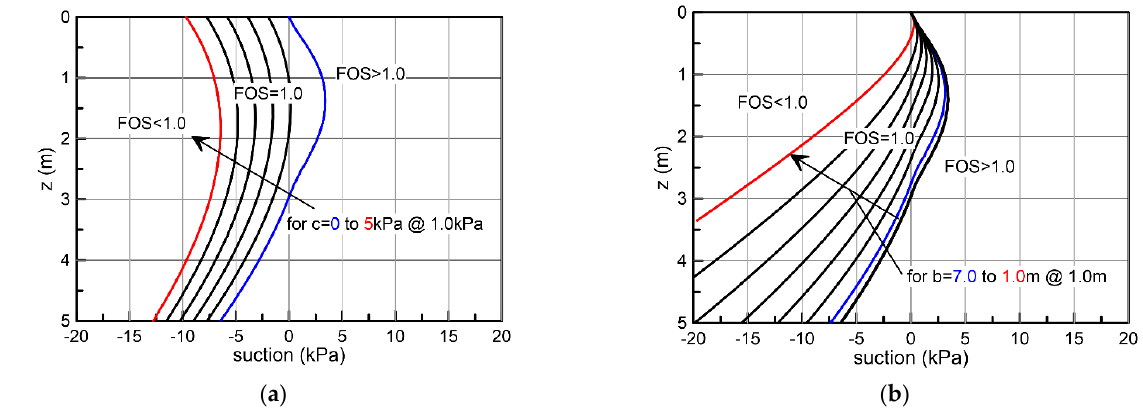
Figure 10. ( a ) Effect of cohesion on the stability chart; ( b ) effect of the 3D mechanism width on the stability chart; results from a 3D mechanism (with lateral resistance).